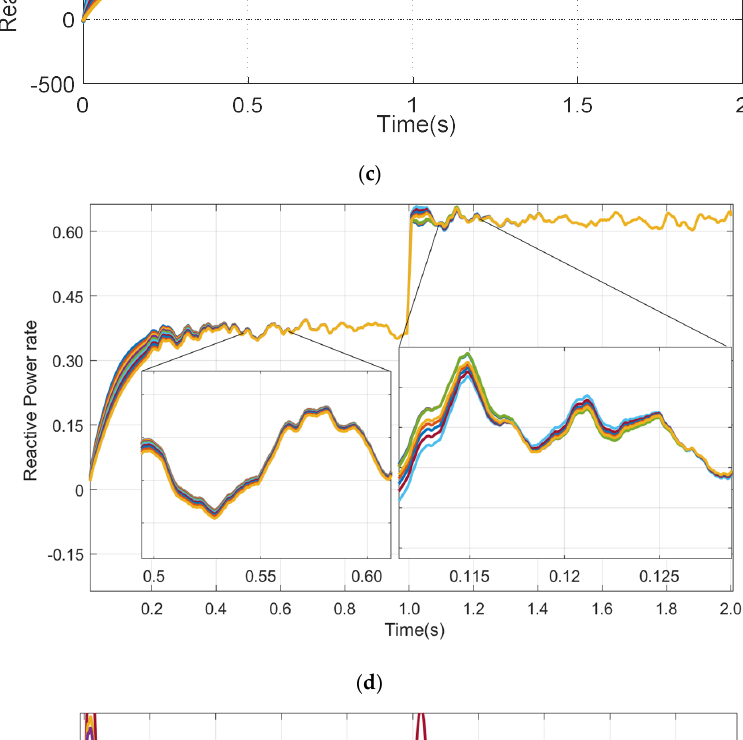
( f ) Figure 17. Simulation results for reactive power output with power generation fluctuation: ( a )–( b ) with periodic communication; ( c )–( d ) with ETCP; ( e ) control input of periodic communication; ( f ) control input of ETCP.